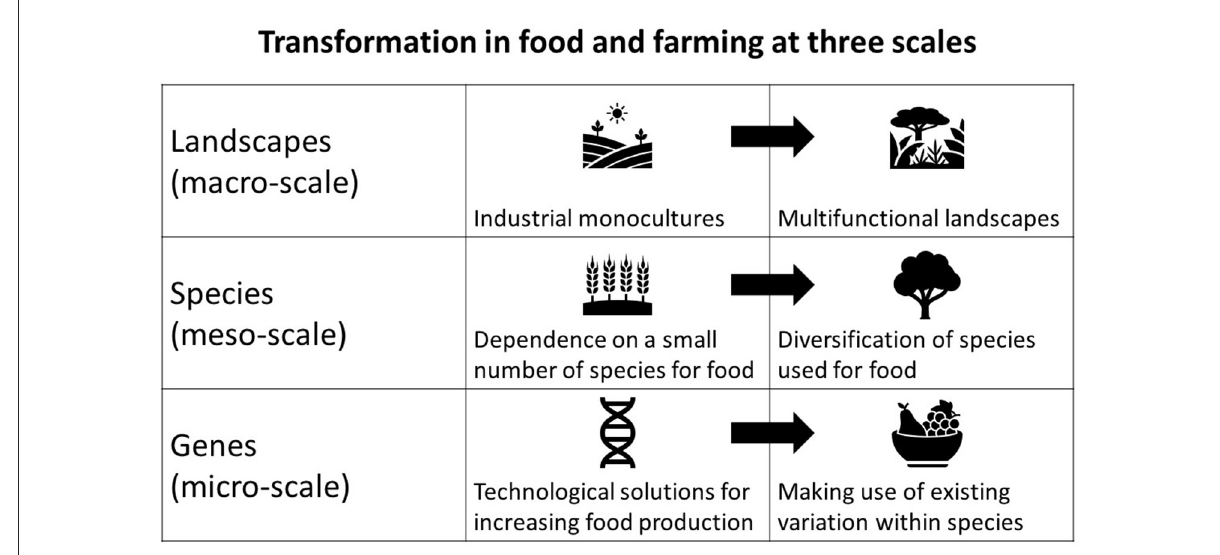
FIGURE1 Schematic representation of the transformation in food and farming sector at three scales. The arrows indicate alternative pathways to promote a food system that is more sustainable in cultural, nutritional and environmental